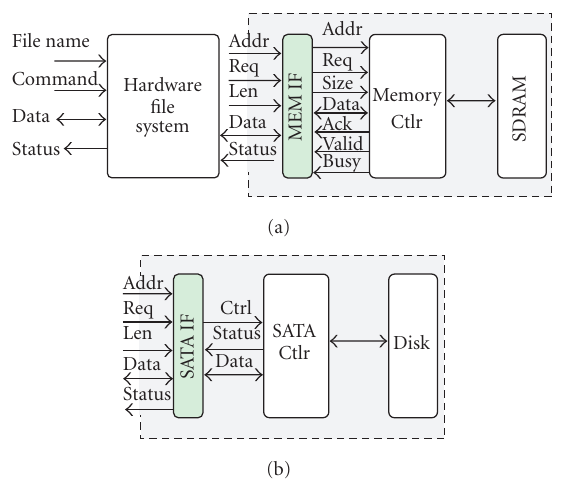
Figure 11: (a) System interface with RAM disk (b) Modular interface with SATA.